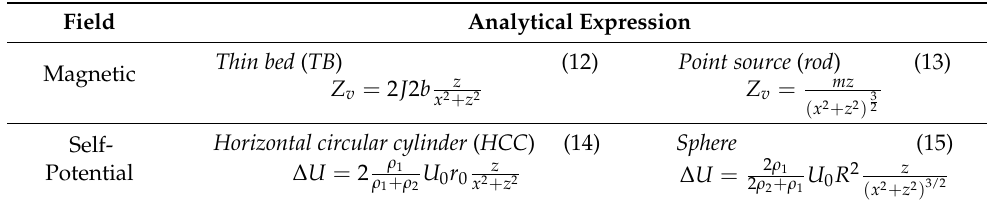
Table 2. Magnetic and SP fields: Comparison of analytical expressions for some interpreting models. Field Analytical